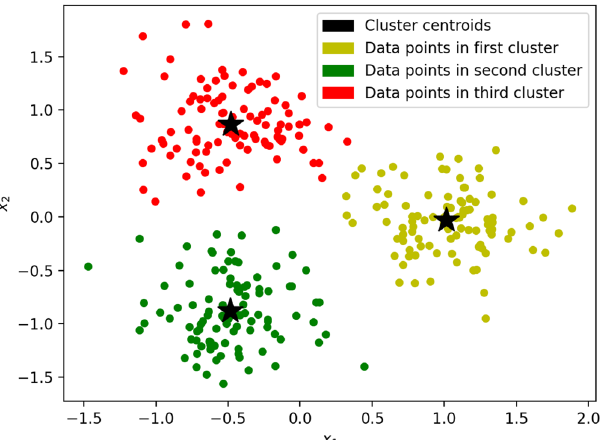
Figure 3. Training a balanced k-means clustering model ( k = 3 ) on training data (yellow, green, and red